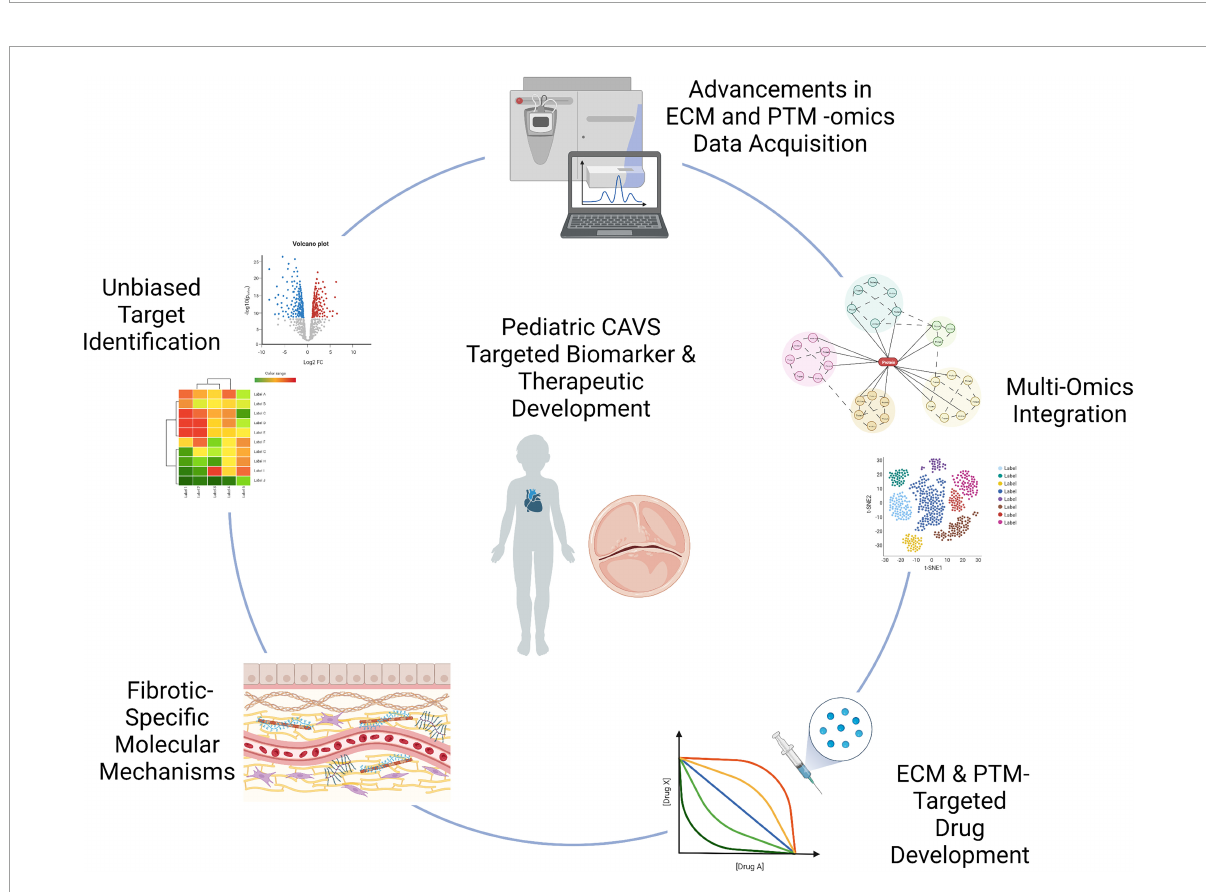
FIGURE5 Graphical summary of technological advancements to be applied to pCAVS. Unbiased approaches, such as proteomics and transcriptomics, allow for novel discovery of disease markers. Advancements in acquisition techniques as described allow for a deeper mining of the extracellular matrisome, previously limited in accessibility. This increased accessibility allows for identification of post-translational modifications; while multi-omics integration probe upstream regulating enzymes, accelerating identification of therapeutic targets. Extracellular matrix targeted -omics techniques have the potential to elucidate fibrosis-specific biomarkers, highlighting the distinct molecular mechanisms between adult calcific and pediatric fibrotic CAVS. Graphics created using BioRender.com